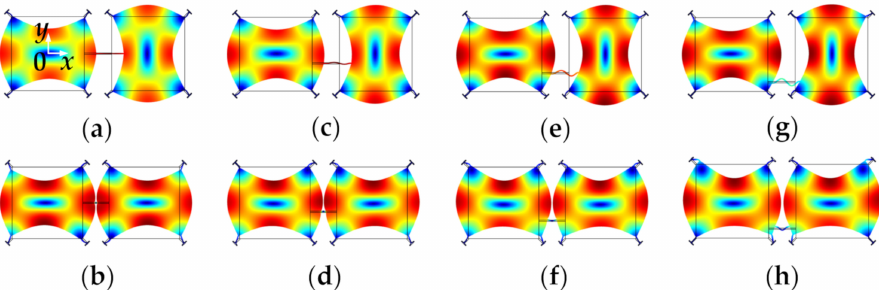
Figure 8. WG modes of a 2-DoF coupled BAW square plate resonator system with the same me- chanical coupling beam located at different positions (represented by y ) simulated in